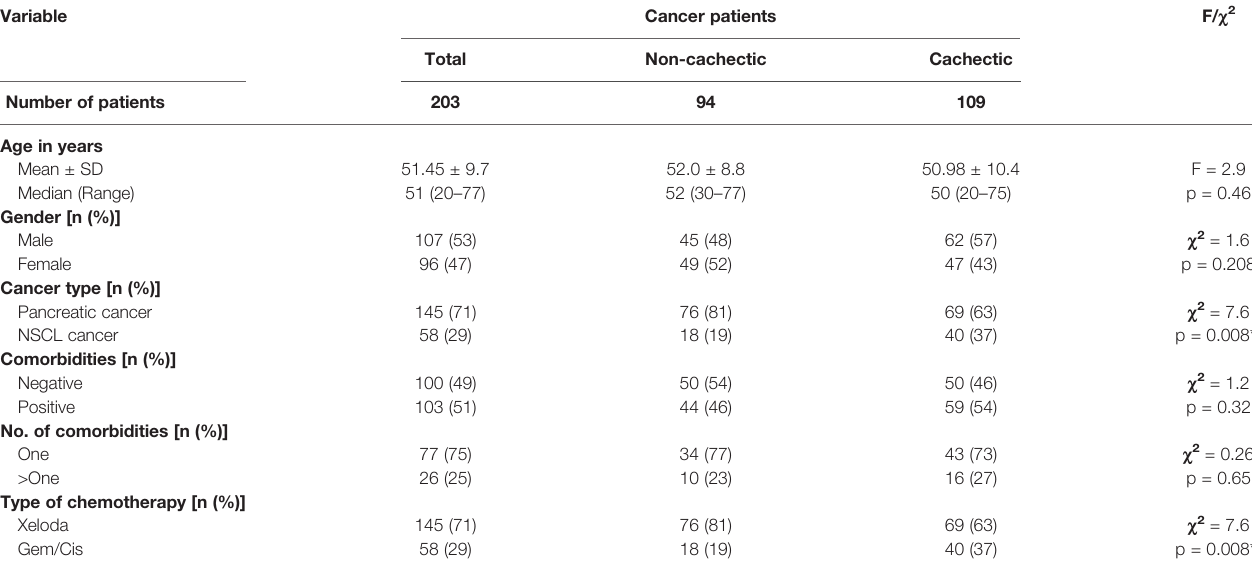
Data are given as mean ± SD, median (minimum – maximum), or n (%). Statistical analysis was carried out using the independent t-test and chi-square test; p ≤ 0.05. Cis, cisplatin; F, independent t-test value; Gem, gemcitabine; n (%), number of cases within the group (percentage); NSCL, non-small cell lung; c 2 , chi-square value. **Signi fi cant difference at p ≤